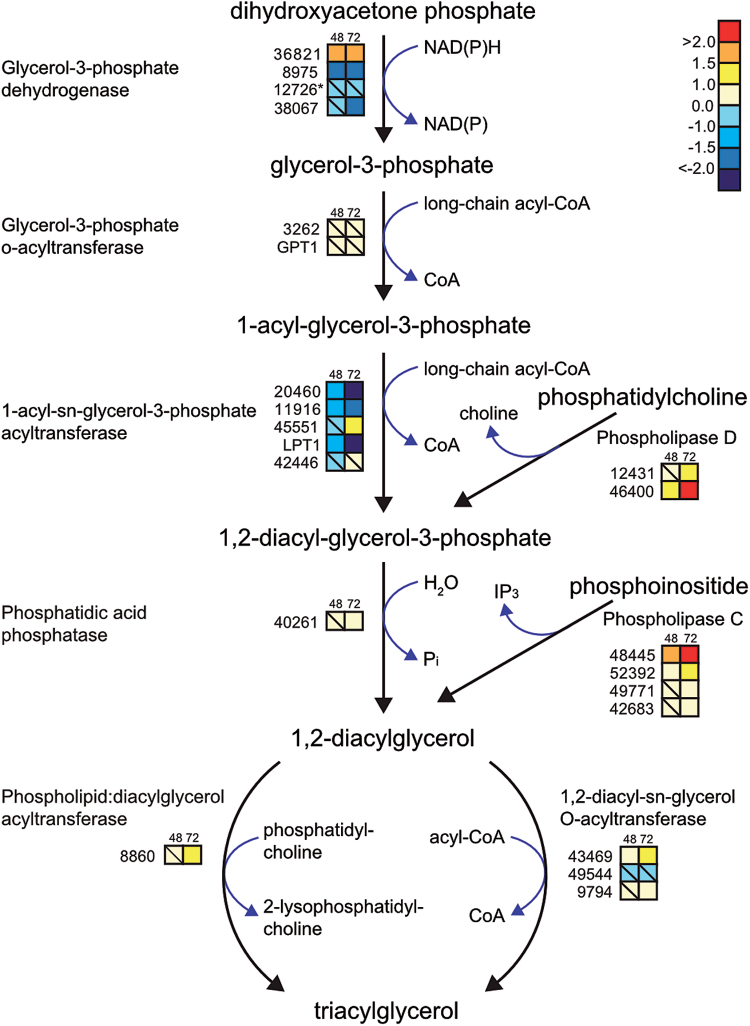
Transcriptional changes in genes related to TAG biosynthesis in response to N deprivation. Coloured squares indicate the regulation pattern of genes encoding putative enzymes functioning in the TAG biosynthetic pathway after 48 and 72h of N deprivation, compared with N-replete cultures. Squares with a diagonal line inside indicate non-significant regulation (P>0.05). The scale on the right represents gene expression ratio values, which were log2 transformed. Numbers indicate Phatr2 gene IDs. Gene ID 12726 (marked with an asterisk) belongs to the Phatr1 database (http://genome.jgi-psf.org/Phatr1/Phatr1.home.html).